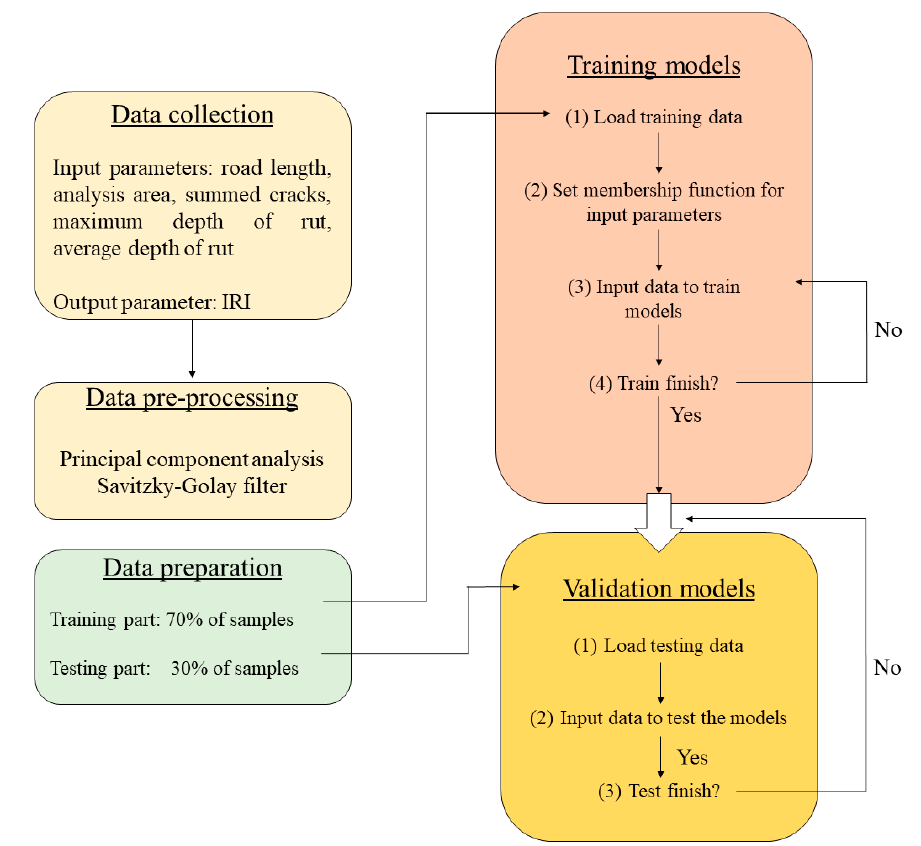
Figure 4. Methodological flow chart of this study.